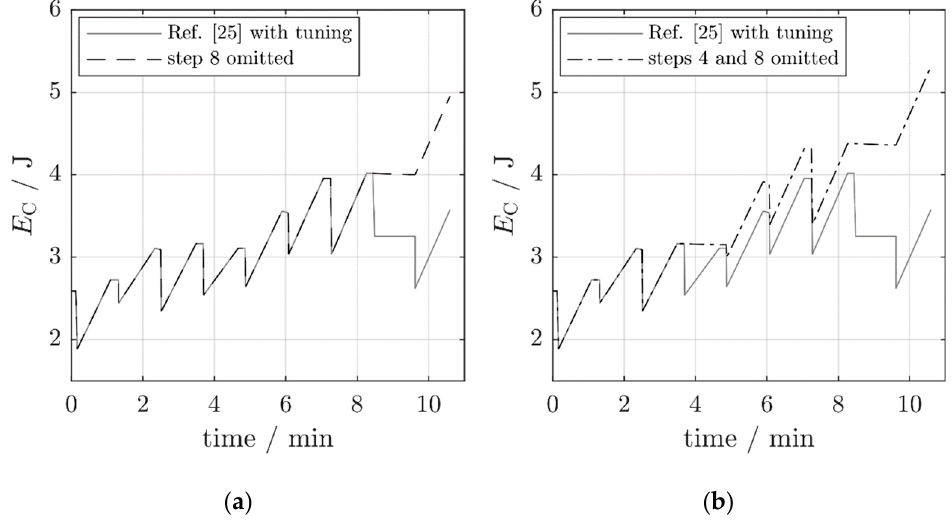
Figure 11. The capacitor energy for various operating modes of the self-adaptive harvester from Reference [25]. ( a ) Periodic adjustment with step 8 omitted. ( b ) Periodic adjustment with steps 4 and 8 omitted.